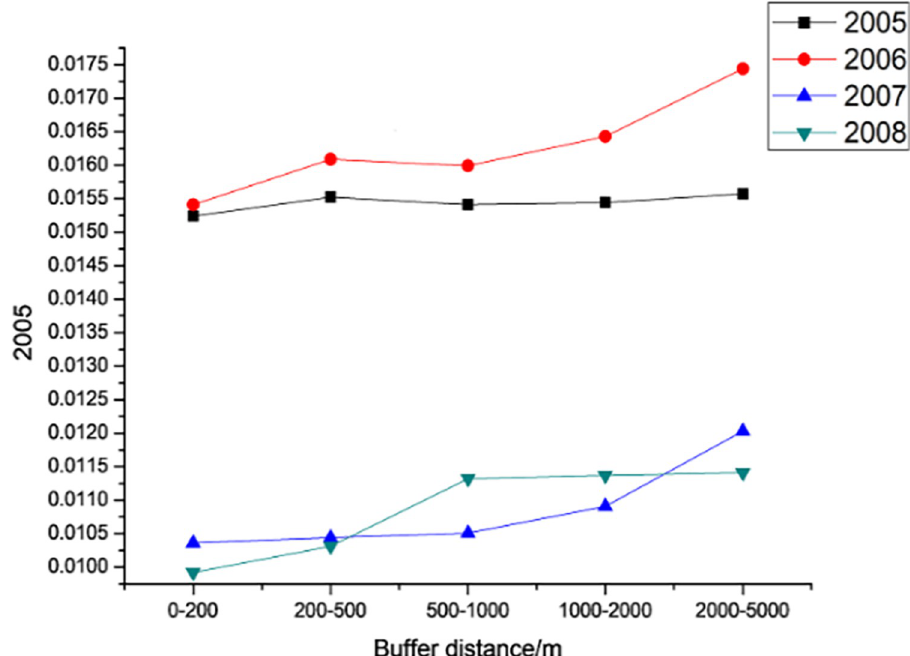
Fig 14. Changes in VSWI by buffer zone of Dongyong Expressway from 2014 to 2016.